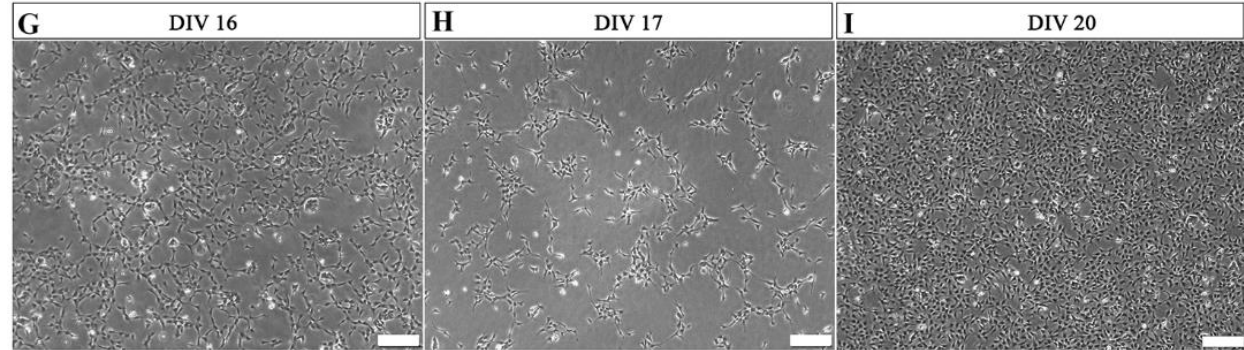
Figure 1. Representative phase-contrast photomicrographs of cells undergoing differentiation from hiPSCs to hiPSC-immatureSCs. Matrigel coating was used during this period. ( A , D , G ) show the morphology of the differentiating cells at 60 – 70% confluence, after 10 days in vitro (DIV 10) ( A ), DIV 13 ( D ), and DIV 16 ( G ), respectively. After this, cells were alternatively passaged to a lower cell density of 2 × 10 5 per well in a 6-well plate (( B ) — DIV 11, ( E ) — DIV 14, ( H ) — DIV 17) or continuously cultured, without splitting, in high cell density (( C ) — DIV 12, ( F ) — DIV 15, ( I ) — DIV 20). DIV = days in vitro. Scale bar: 200 µm.